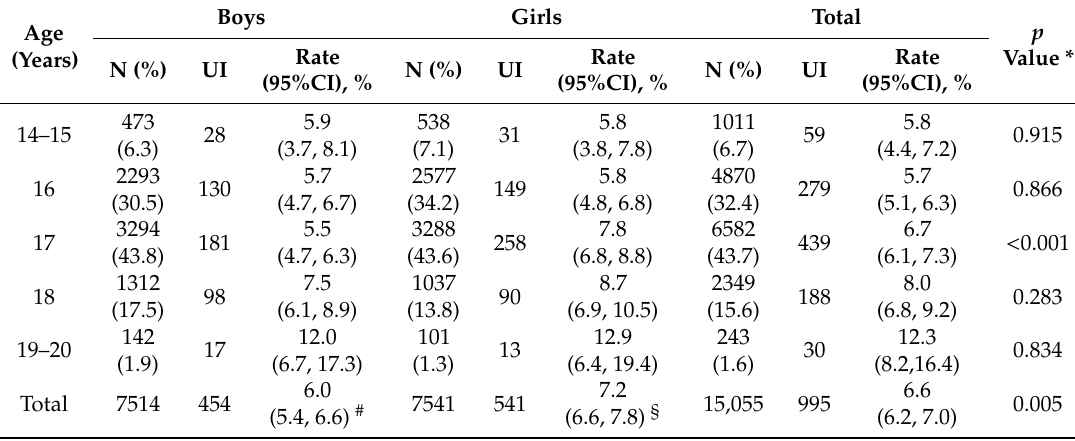
Table 2. Prevalence of UI in di ff erent age